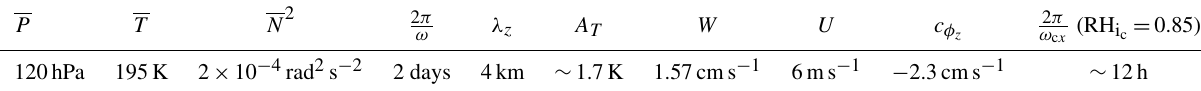
Table 1. Wave and background state characteristics assumed for the sedimentation–growth simulations reported in this section. ¯ P : average pressure (for the simplified system), ¯ T : average temperature (for the simplified system), ¯ N : background Brunt–Väisälä frequency, 2 π period, λ z : wave vertical wavelength, A T : wave (Eulerian) temperature amplitude, W : wave vertical wind amplitude, U : wave zonal wind = ω amplitude, c φ : wave vertical phase speed, 2 π : period of the oscillations of the crystals around the elliptic point (Eq. 29). m ω c x z